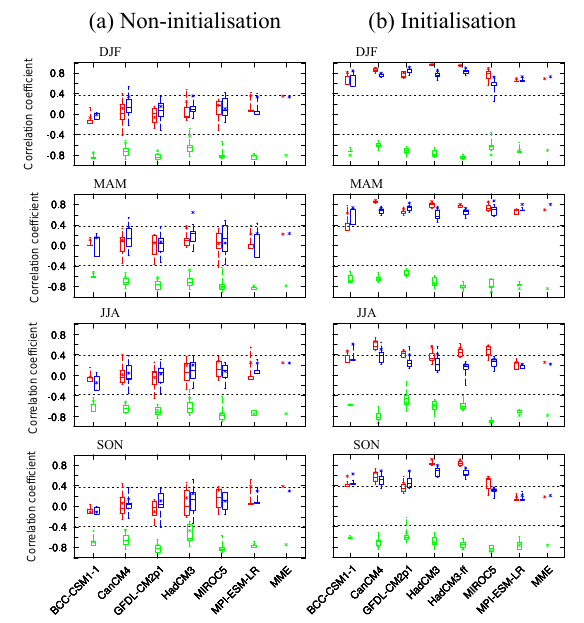
Figure 7. Model prediction skill of Niño3.4 (red) and SOI (blue) from DJF to SON in non-initialised (a) and initialised (b) simu- lations. Green diagrams show the correlation coefficient between the model simulation of Niño3.4 and the SOI. Box and whisker di- agrams show the ensemble mean of each model (asterisk), median (horizontal line), 25th and 75th percentiles (box), and minimum and maximum (whisker). The two black dotted lines indicate the 0.05 significance level based upon a Student’s t